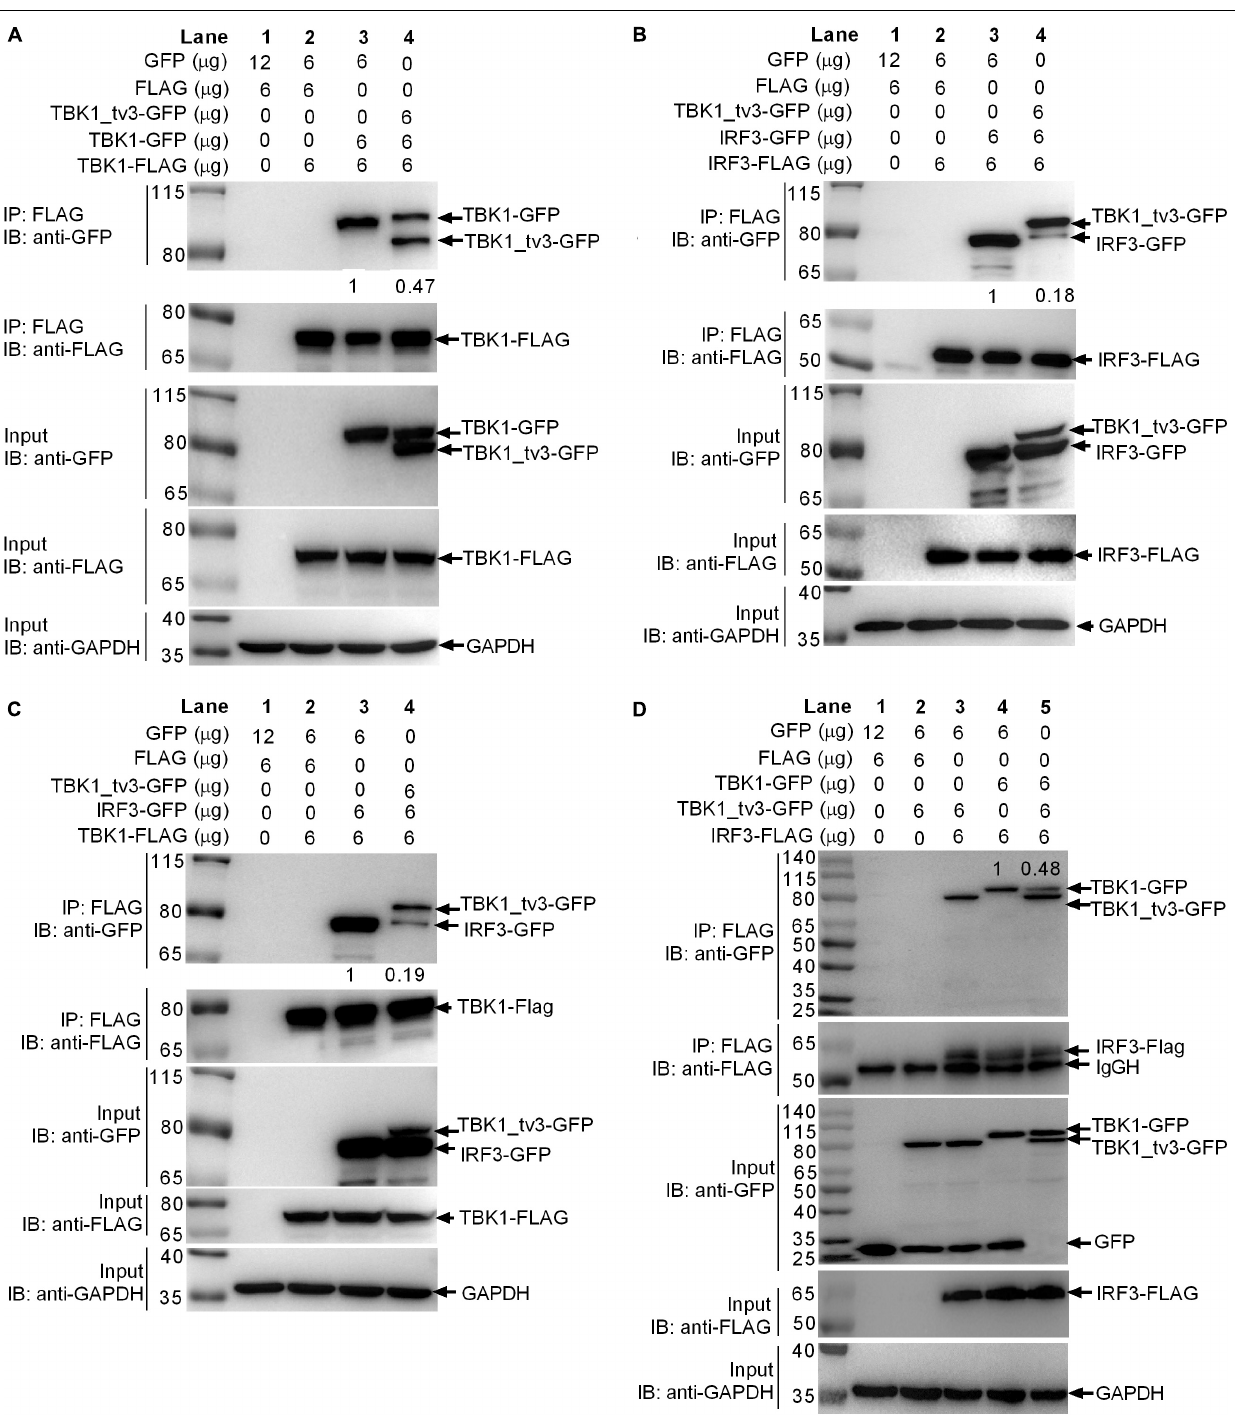
Frontiers in Immunology |